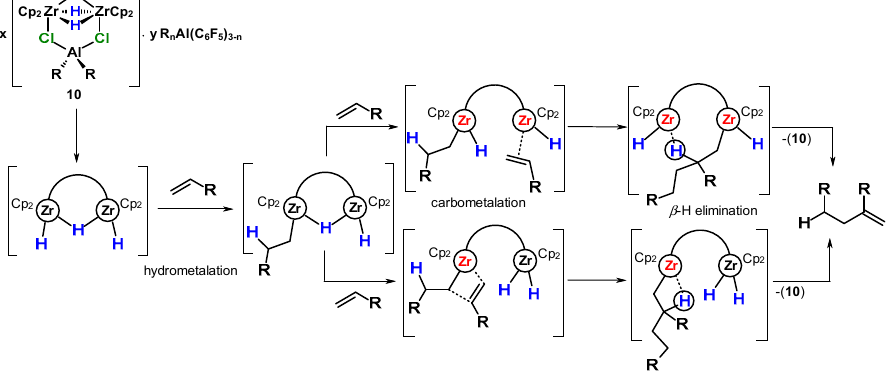
Figure 5. The formation of cationic complexes in the Cp 2 ZrCl 2 -HAlBu i2 -(Ph 3 C)[B(C 6 F 5 ) 4 ]